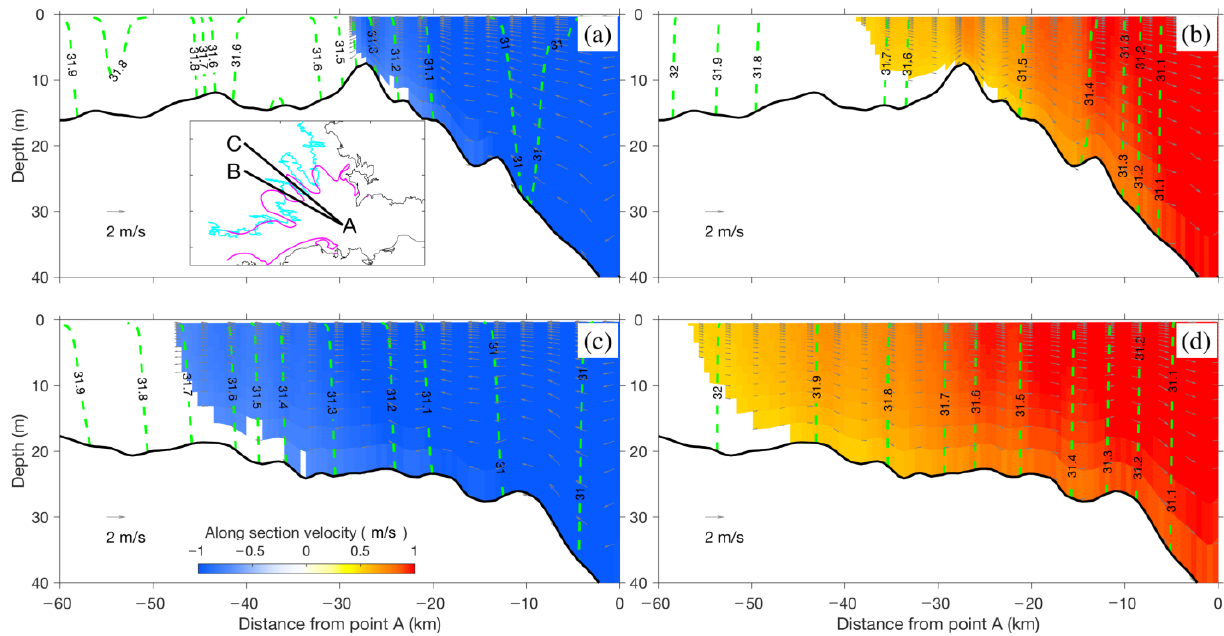
Figure 6. The u velocity field (i.e., along-section velocity component, blue-orange contour), isotherms (green lines), and u-w velocity vectors (i.e., along-section and vertical velocity vectors, gray arrows) along section AB under westward ( a ) and eastward ( b ) tidal current. ( c , d ) The same as ( a , b ), but for section AC, respectively. Note that westward (eastward) current under 0.7 (0.5) m/s is blanked. Sections AB and AC are shown in embedded axes in ( a ), data in this figure are based on EXP_D45.